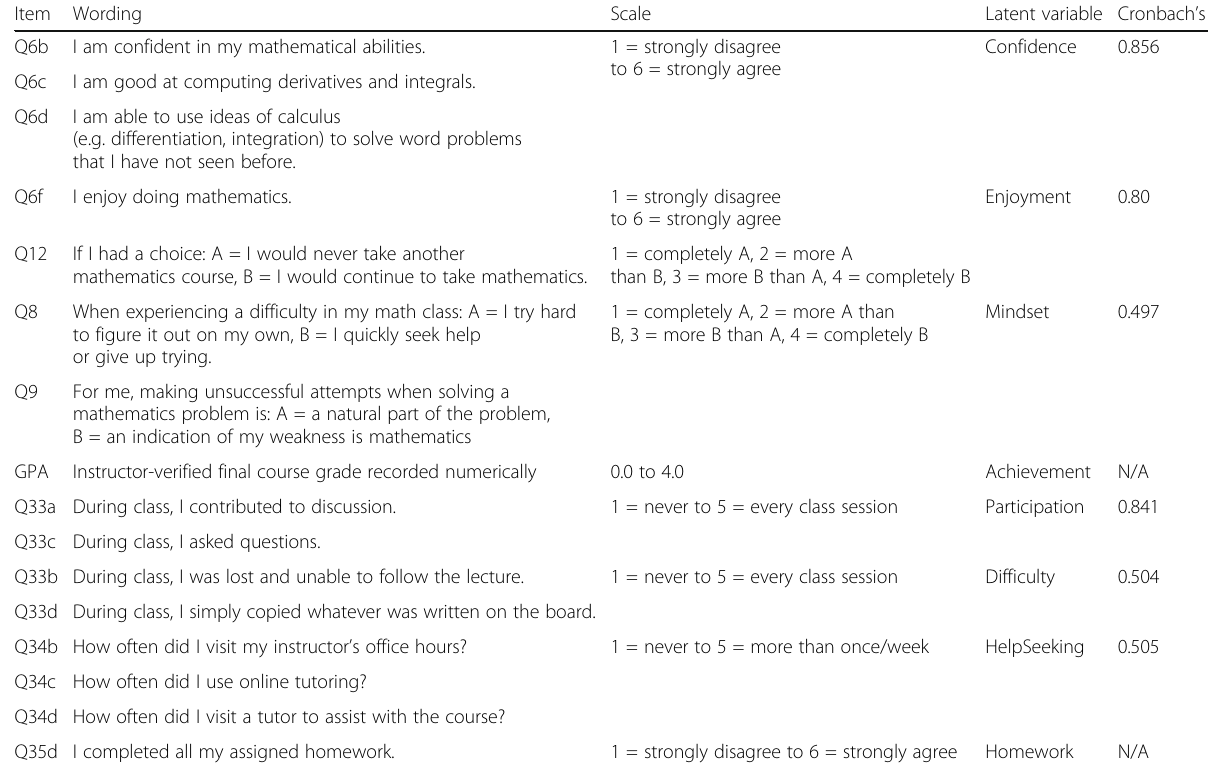
Table 1 Survey items and latent